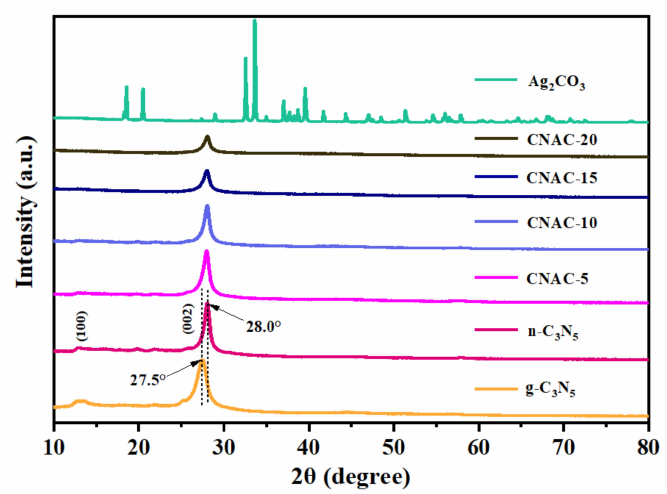
Figure 3. XRD patterns of as-prepared